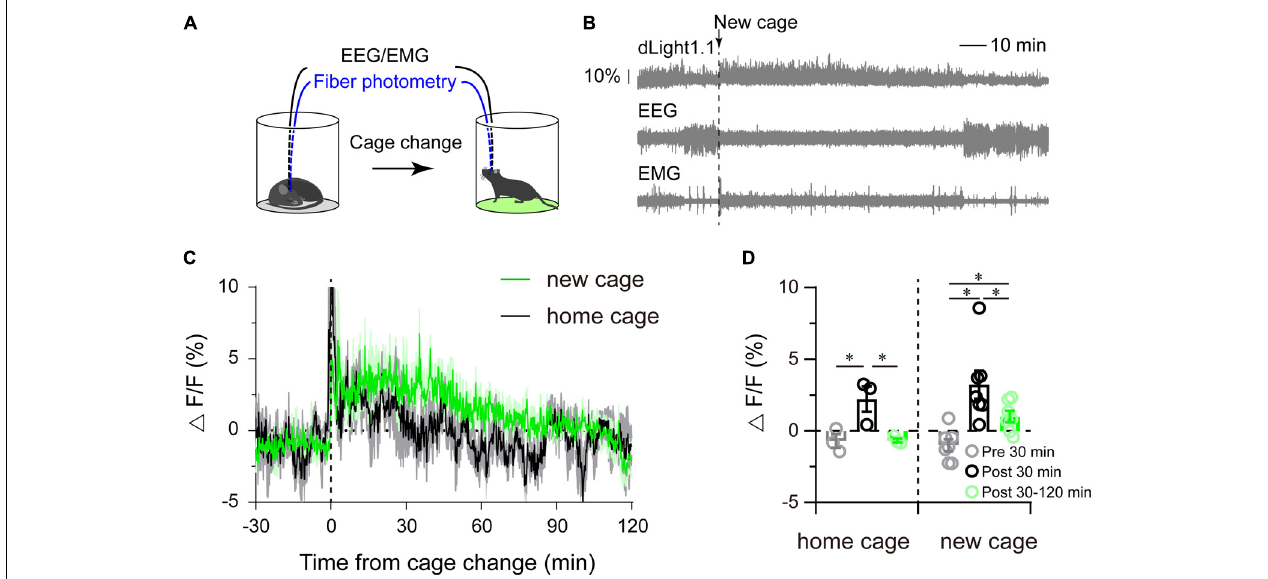
FIGURE 4 | Striatal dLight1.1 fluorescent signal in response to a new environment. (A) Schematic showing the cage-change procedure, where mice were moved to a new cage. (B) A typical example of the fluorescence signal, EEG, and EMG traces before and after the cage-change. (C) Time course of the striatal dLight1.1 signal in response to the cage-change, (black is to home cage, green is to new cage). (D) Average striatal dLight1.1 signal 30 min before, 30 min and 30–120 after the cage change to home cage or new cage (one-way ANOVA, home cage: F 2 , 4 = 7.284, P = 0.0464; new cage: F 2 , 12 = 10.1832, P = 0.0026. post comparisons followed by PLSD).